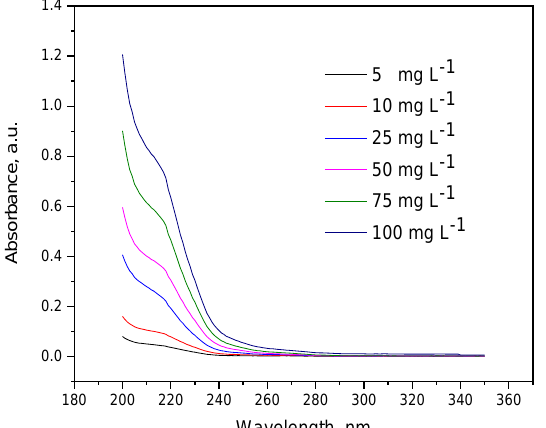
Figure 2. UV/Vis spectra of aqueous solutions of malathion at various concentrations.